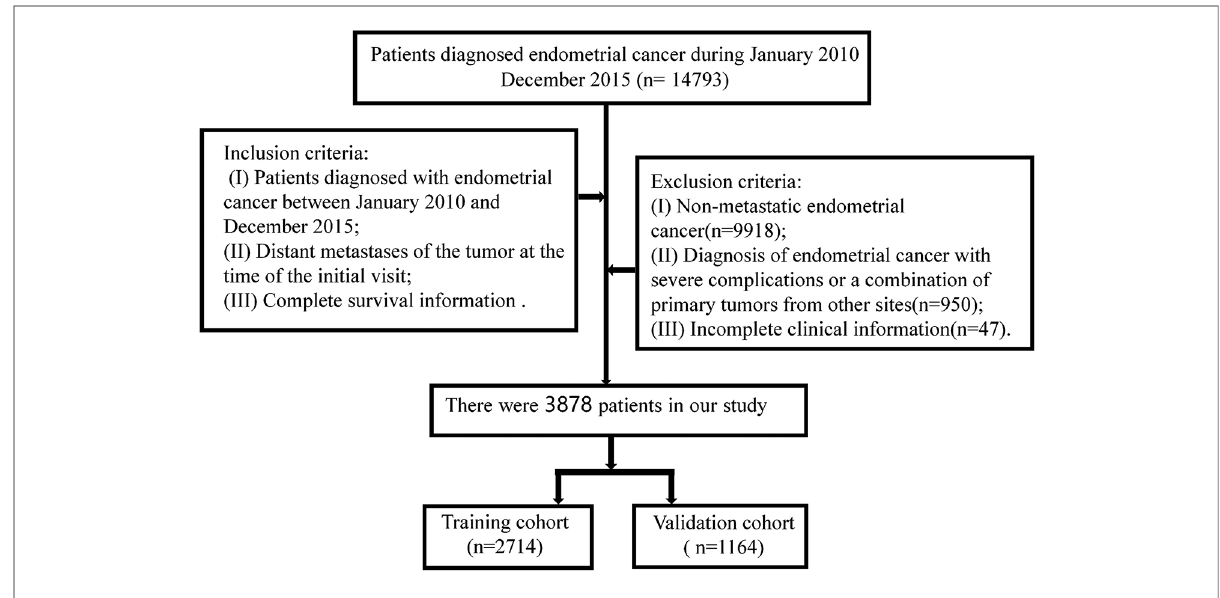
FIGURE 1 Flow chart for screening patients with metastatic endometrial